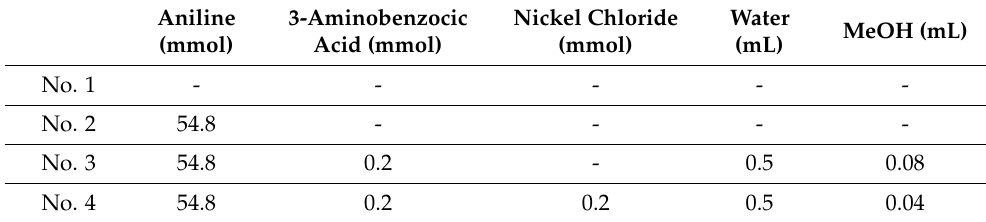
Table 1. Preparation condition of precursors for AC plasma